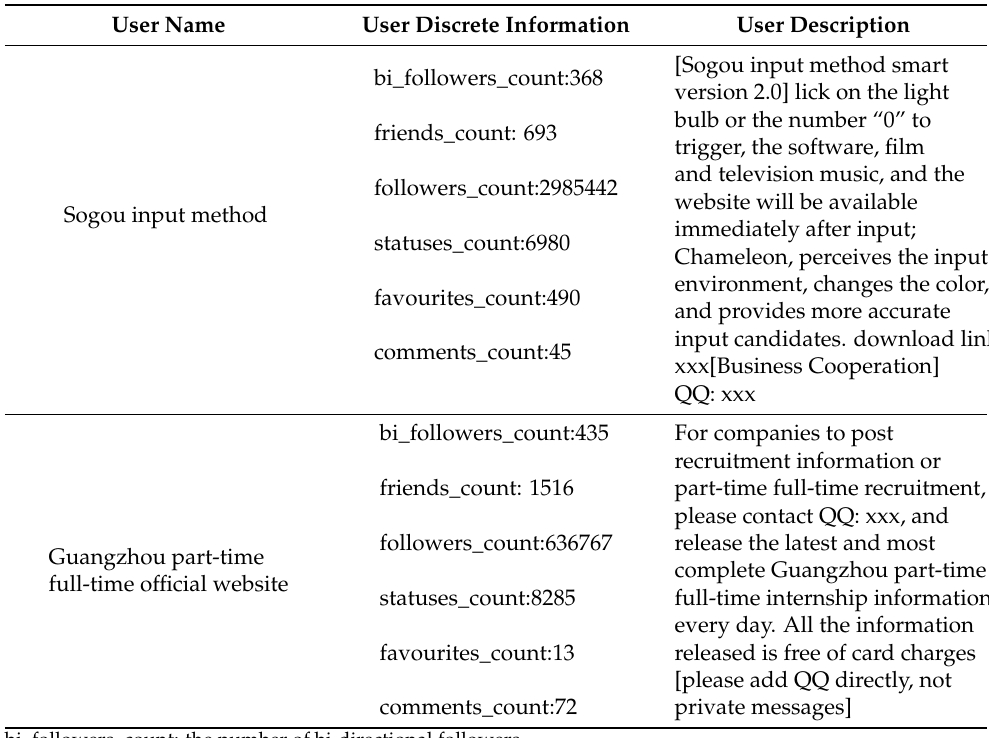
Table 1. Examples of social media user